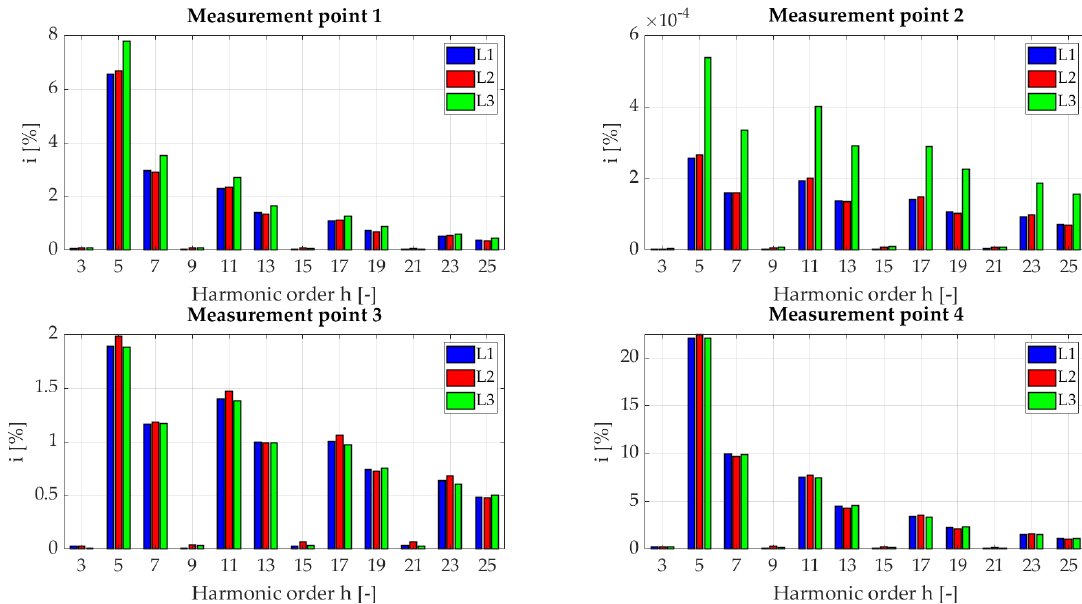
Figure 35. Current harmonic spectrum at the measurement points.